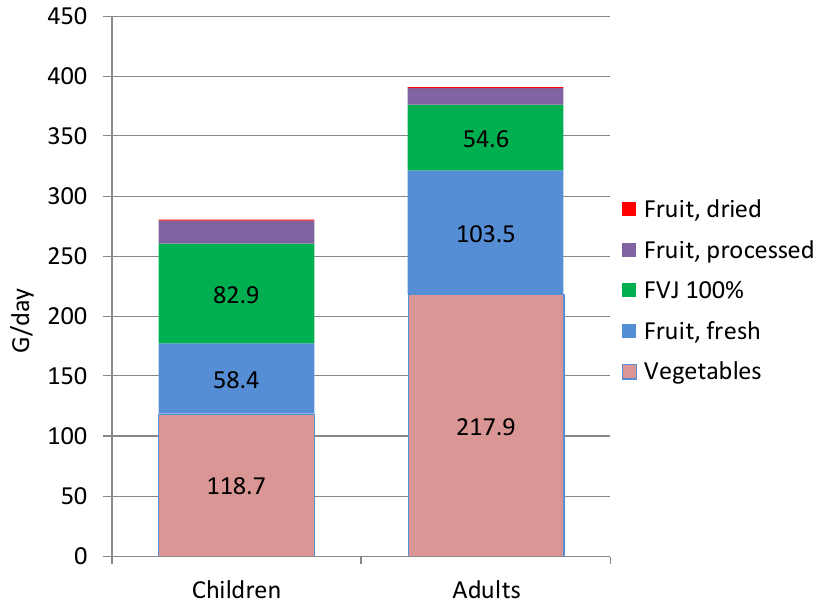
Figure 1. Contribution of vegetables, whole fruit, and FVJ (fruit and vegetable juices) to total fruit and vegetable consumption of children and adults (in g/day).